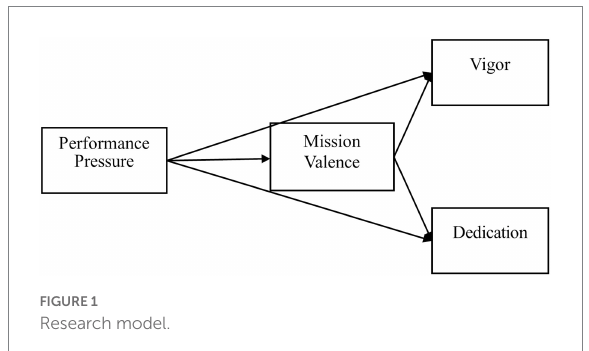
FIGURE 1 Research